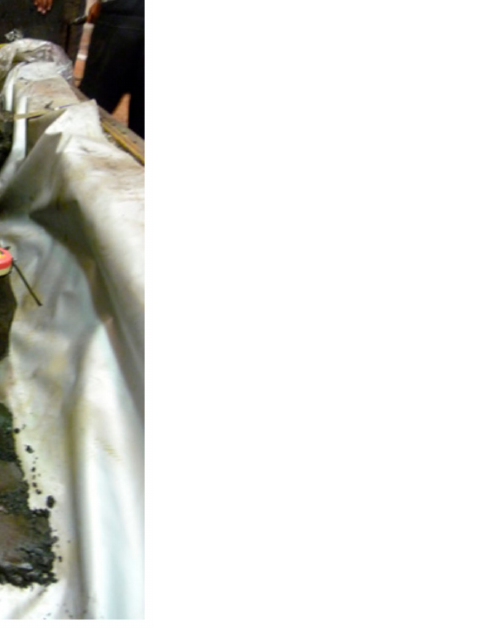
Figure 6. The coal blocks cemented to each other by a mixture of gudron (Source: own elaboration).